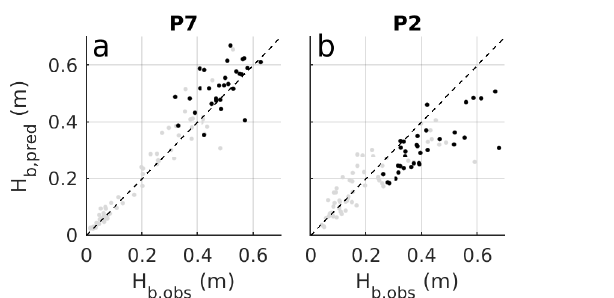
Figure 9. H b , pred as a function of H b , obs at P7 ( a ) and P2 ( b ) for the subset of data with small currents ( | U N | < 0.1 m/s) with black markers for (near-)breaking conditions ( As < − 0.2) and gray markers for non-breaking